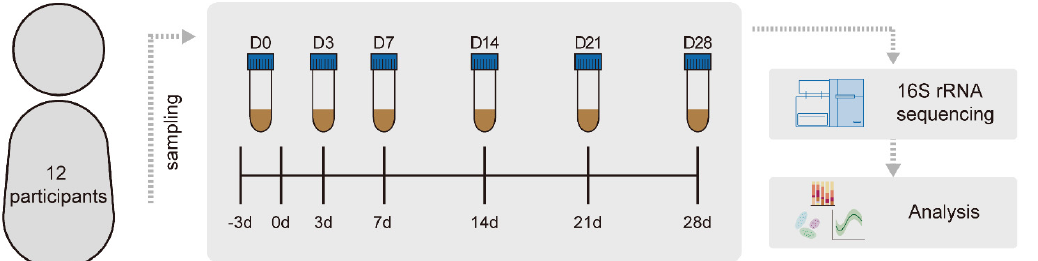
Figure 1. Schematic of population experimental design and collection protocol. Twelve participants were sampled at 6 time points before and after bowel